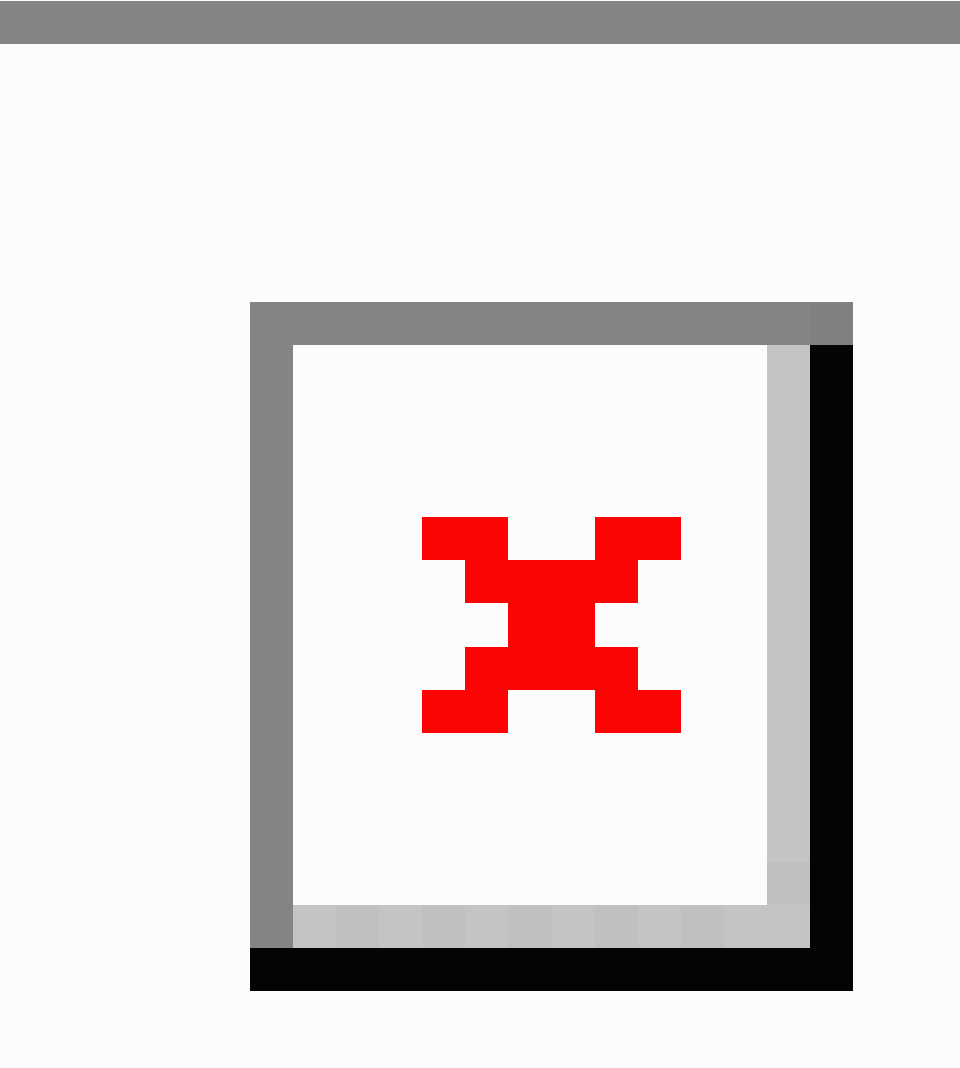
Figure 7. Sensor technology and the use of portable communication devices offer the possibility of storing and accessing data from our daily life to improve self-knowledge. Insights gained by performing these measurements can be used, for example, to change life-threatening habits, adopt a healthier lifestyle, or take more informed treatment